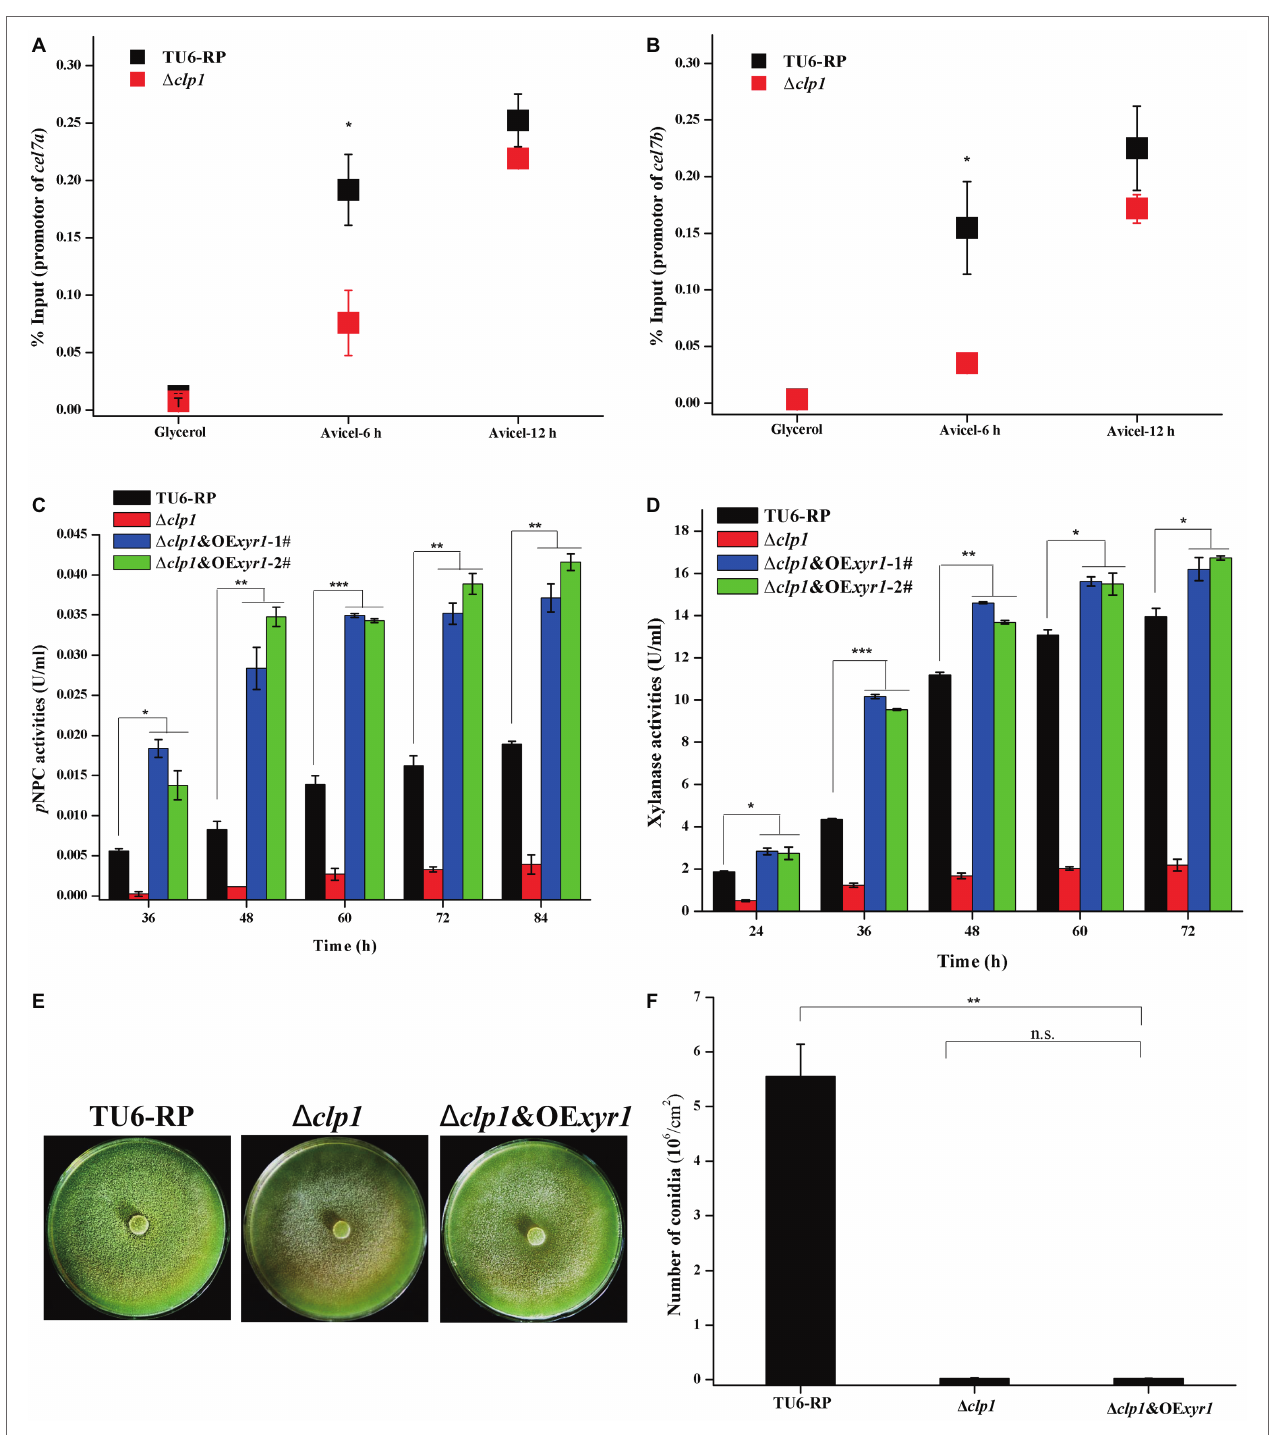
FIGURE 6 | Overexpression of XYR1 fully rescued the defect in cellulase production but not conidiation resulting from clp1 deletion. (A,B) ChIP analyses of XYR1 occupancy on cel7a (A) and cel7b (B) promoters in the Δ clp1 and TU6-RP strains after cultivation on 1% (v/v) glycerol or 1% (w/v) Avicel for 6 and 12 h. (C,D) Extracellular p NPC hydrolytic activities (C) and xylanase activities (D) of the culture supernatant from TU6-RP, Δ clp1 , and Δ clp1 &OE xyr1 strains cultured on 1% (w/v) Avicel or 0.5% (w/v) xylan. (E,F) Conidia formation of the control strain TU6-RP, Δ clp1 , and Δ clp1 &OE xyr1 strains incubated on malt extract agar plates at 30°C for 5 days (E) and conidia counting (F) . Significant differences ( t test, * p < 0.05, ** p < 0.01, *** p < 0.001) were observed in the (hemi)cellulase production and conidiation between the control strain TU6-RP and the Δ clp1 &OE xyr1 strain. Values represent the mean of three biological replicates. Error bars are the SD from these